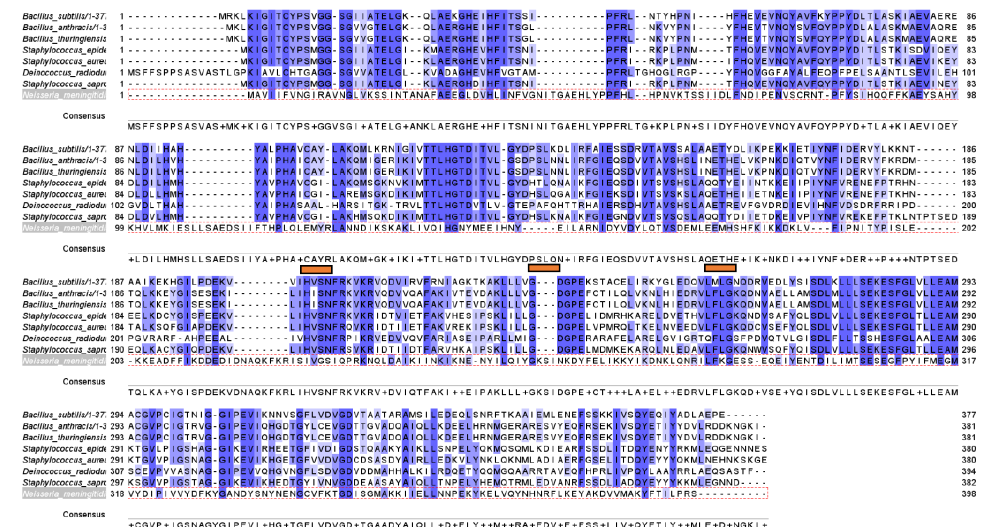
Figure 6. Comparison of NmW-GT with BshA sequences from different species. Blue highlights regions of conservation, and the gold bars highlight regions that interact with the substrate in BshA enzymes and that are not conserved in NmW-GT.